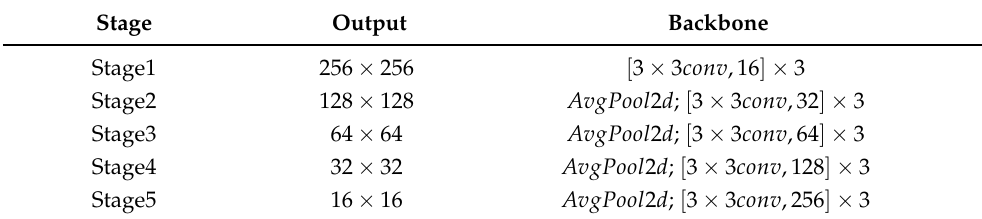
Table 1. The design details of different stages of backbone in